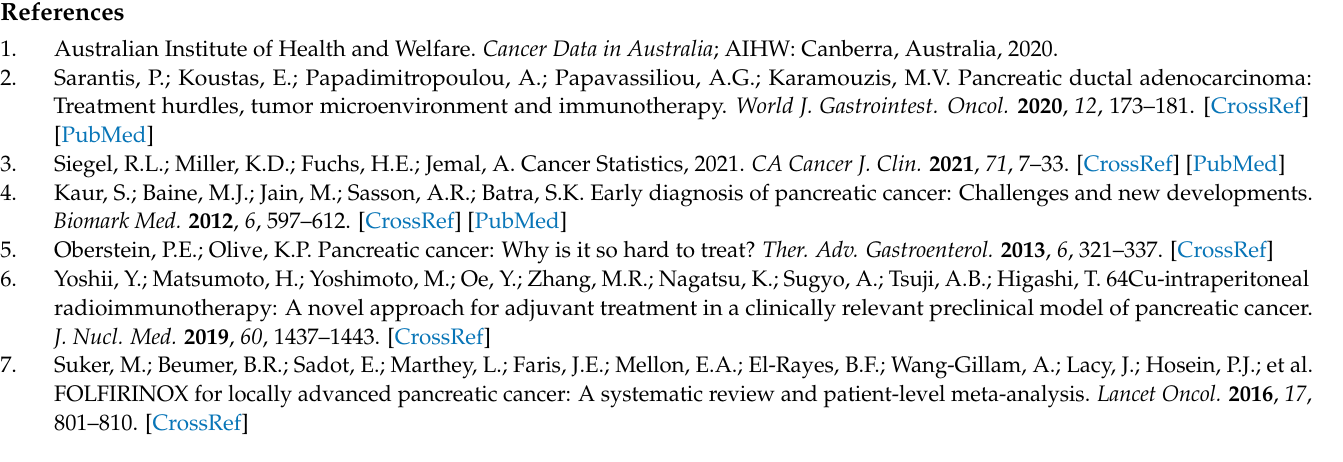
Figure S3: Mass spectra of light chain p-SCN-Bn-DOTA-C595 conjugate stored in 0.1 M ammonium acetate (pH 6.4) at 37 ◦ C at A, day 0 and B, day 7; Figure S4: Mass spectra of heavy chain p-SCN-Bn- DOTA-C595 conjugate stored in 0.1 M ammonium acetate (pH 6.4) at 37 ◦ C at A, day 0 and B, day 7; Figure S5: Mass spectra of light chain p-SCN-Bn-DOTA-C595 conjugate stored in 0.1 M ammonium acetate (pH 7.4) at 37 ◦ C at A, day 0 and B, day 7; Figure S6: Mass spectra of heavy chain p-SCN-Bn- DOTA-C595 conjugate stored in 0.1 M ammonium acetate (pH 7.4) at 37 ◦ C at A, day 0 and B, day 7; Figure S7: Mass spectra of light chain p-SCN-Bn-DOTA-C595 conjugate stored in PBS (pH 7.4) at 4 ◦ C at A, day 0 and B, day 30; Figure S8: Mass spectra of heavy chain p-SCN-Bn-DOTA-C595 conjugate stored in PBS (pH 7.4) at 4 ◦ C at A, day 0 and B, day